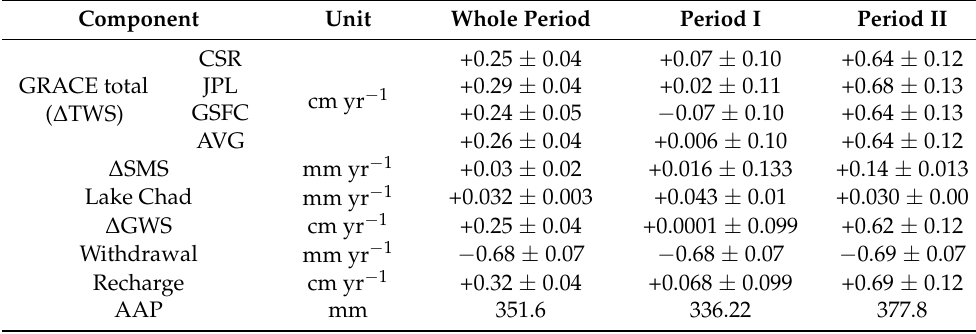
Figure 3. AAP (mm) was extracted from the TRMM data over the study area. Table 1. Partitioning of terrestrial water storage ( ∆ TWS) in the study